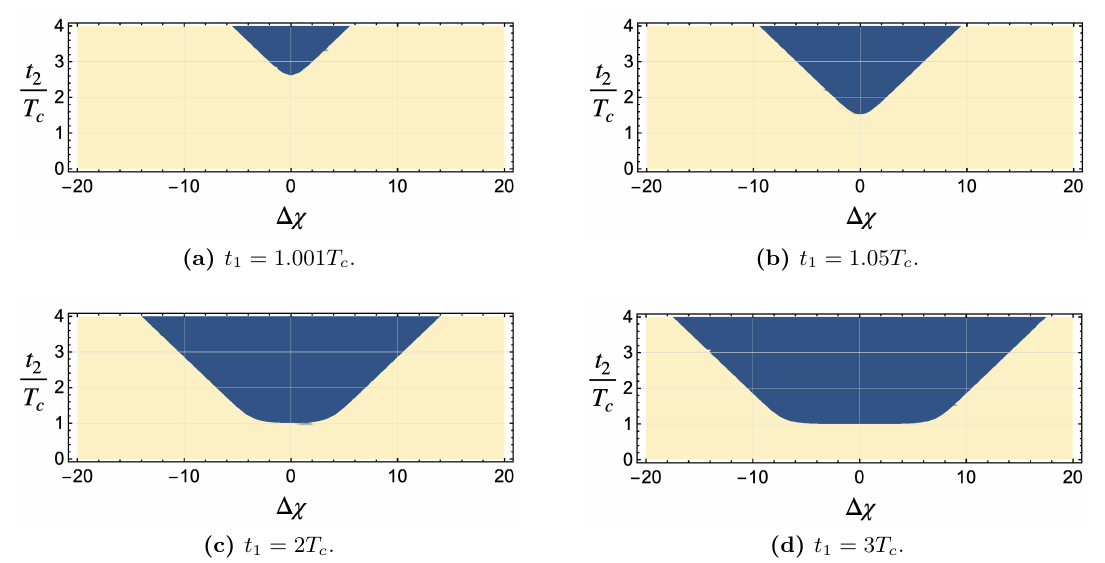
Figure 5. Blue region (the light-cone like region) in the space of ( t 2 /T c , ∆ χ ) where the imaginary part of C probe takes non-zero values. The light-cone like region only appears for t 2 ≥ | T c | and | t 1 | > | T c | . The commutator diverges when ψ L and ψ R are light-like separated (the boundary of the blue region), and its value decreases very quickly to zero as move to the region inside the blue region, taking non-zero values in the blue regions shown above. Here we set t 0 = 0 , ∆ O = 1 . 4 , and G N = 1